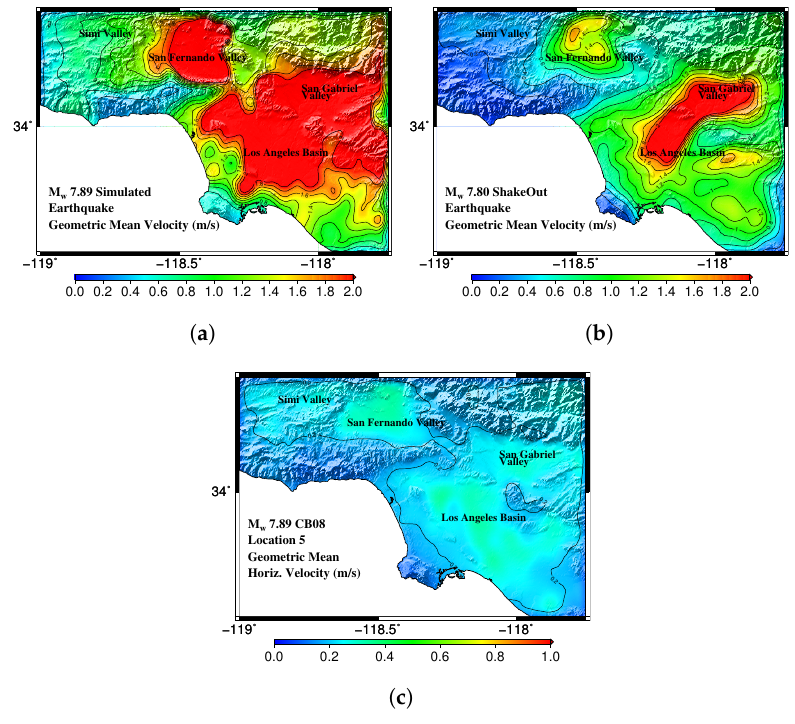
Figure 10. Geometric mean of peak horizontal ground velocities under the ( a ) simulated M w 7.89 south-to-north propagating scenario earthquake at location 5, ( b ) the south-to-north propagating M w 7.80 ShakeOut scenario earthquake rupturing the San Andreas fault from Bombay Beach in the south to Lake Hughes in the north, and ( c ) the predictions by the CB-08 NGA